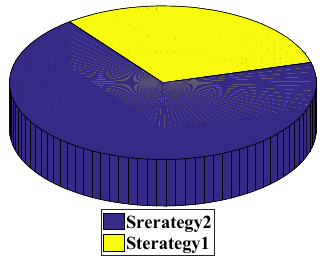
Figure 11. The total cost of the grid for strategy 1 and strategy 2.